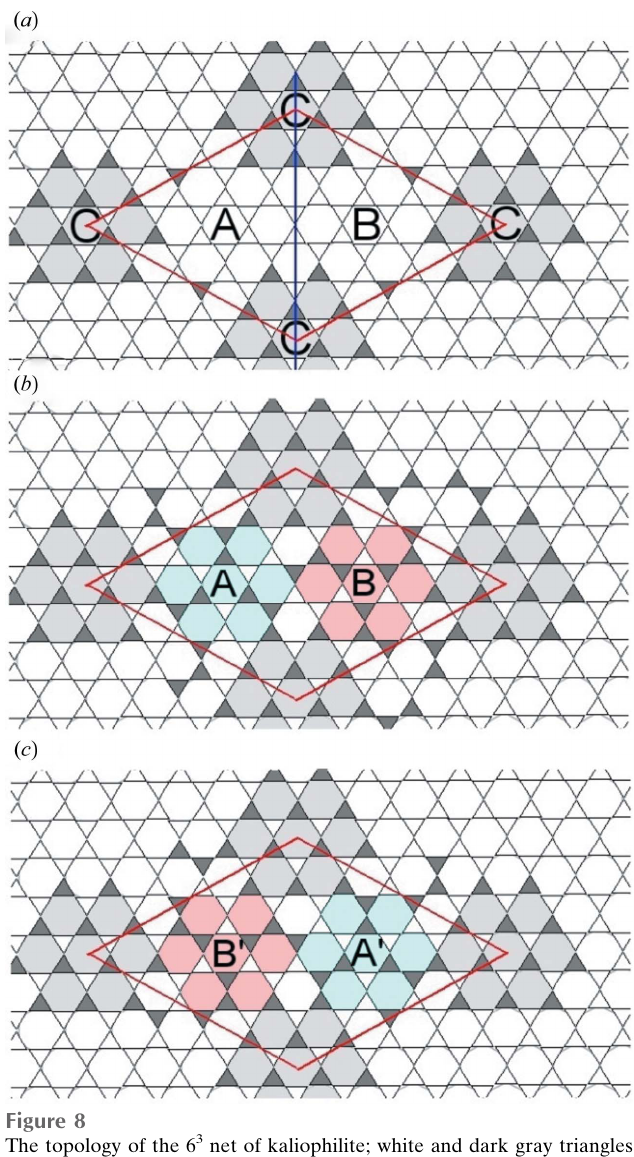
Figure 8 The topology of the 6 3 net of kaliophilite; white and dark gray triangles represent tetrahedra pointing down and up, respectively. In all the images, ( a ), ( b ) and ( c ), the shaded hexagons (corolla C) correspond to rings where tetrahedra do not change their orientation in space after reflection in (1-10). In ( a ) the trace of one of the three mirror planes (1-10), valid only for corolla C, is indicated in blue. ( b ) The topology of kaliophilite with corolla A (in blue) and corolla B (in red), which are related to each other by the translation vector t AB = (1/3) a (cid:2) (1/3) b + (1/2) c . ( c ) The topology of the twin individual, with corolla A 0 (in blue), which is obtained by reflecting A across (1-10), and corolla B 0 (in red), which is obtained by reflecting B across